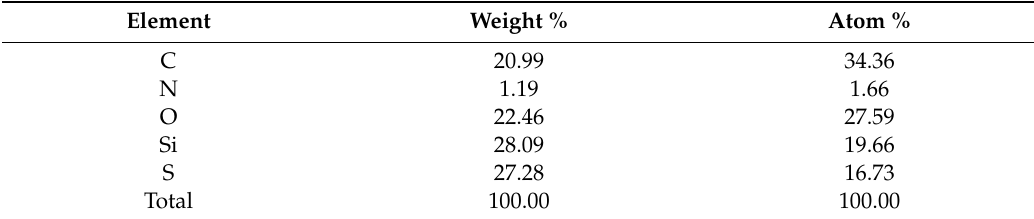
Table 1. (EDX) data of adsorbent 1 before adsorption.